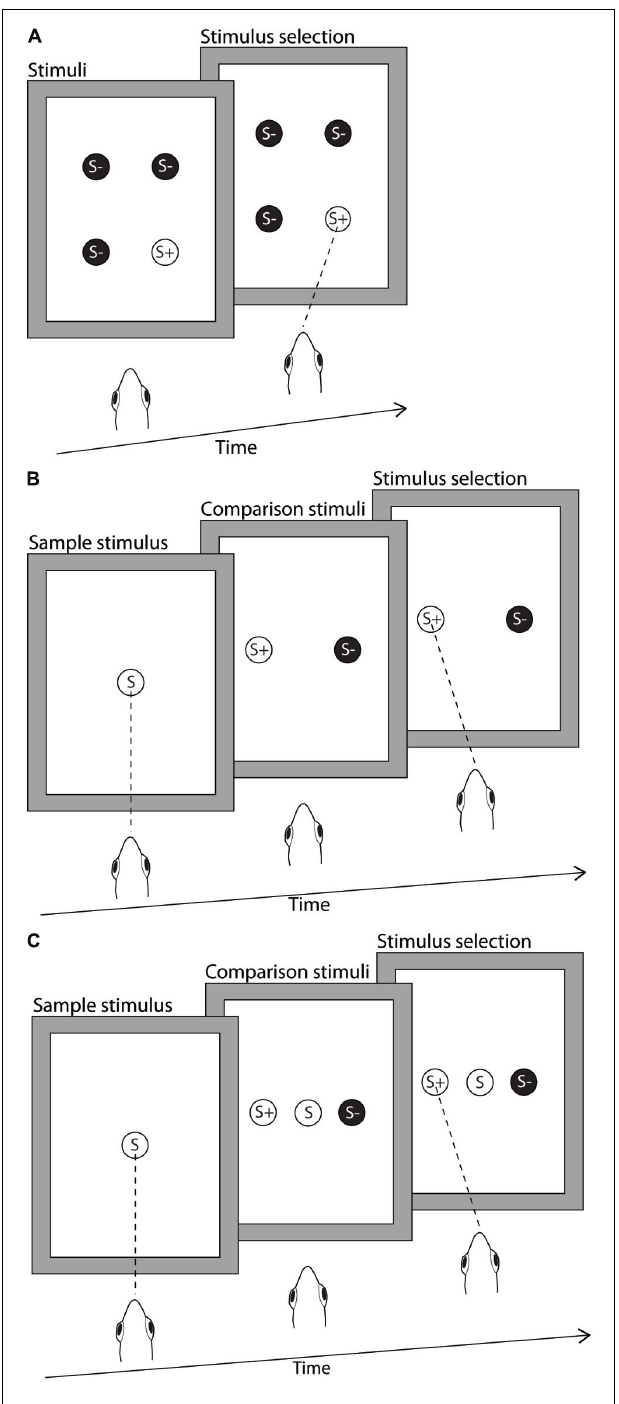
FIGURE 1 | Illustration of the stimulus presentation protocols used in the delayed and simultaneous matched-to-sample/oddity-from- sample (MTS/OFS), and the odd-one-out (OOO) task. Stimuli were a range of black line drawings (not drawn to scale in figure) on a white background, presented on a computer monitor suspended directly above the aquarium. (A) Odd-one-out.The archerfish were presented with four stimuli, three identical S − and one different S + .These stimuli could appear in any of four possible positions on the monitor.The archerfish